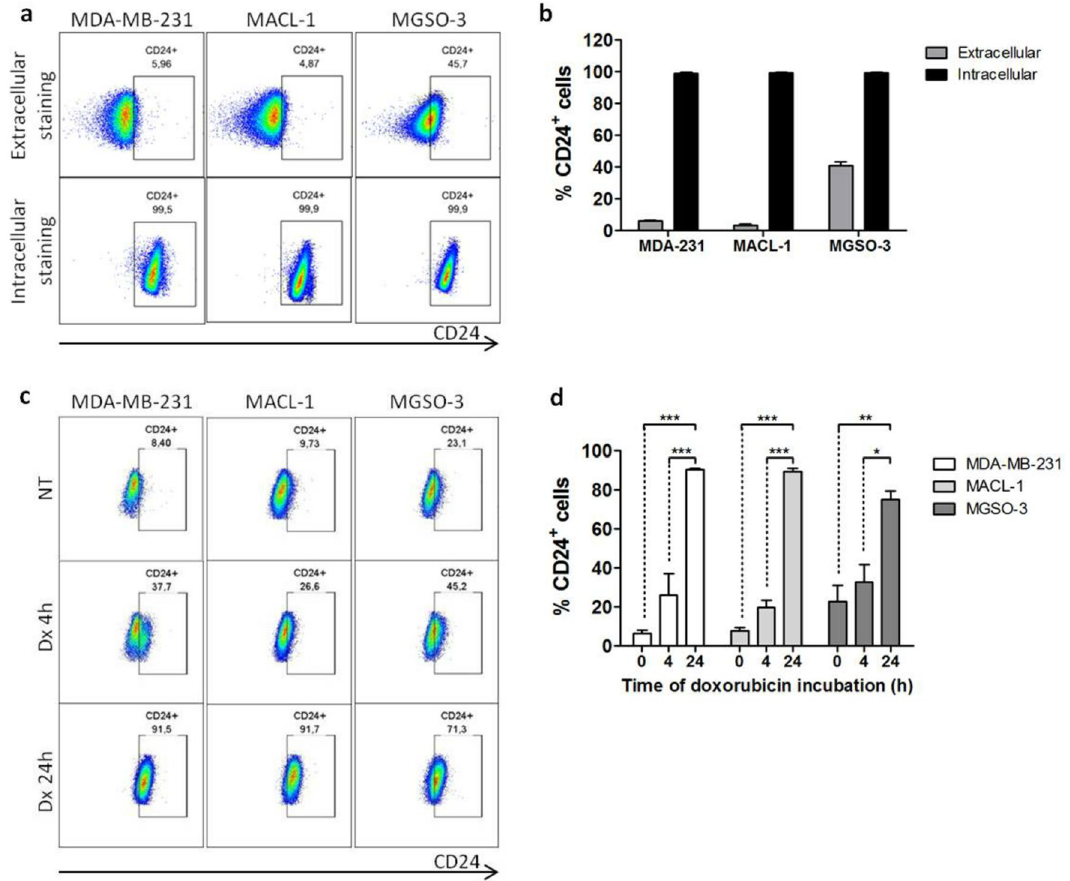
Figure 2. Translocation of CD24 from cytosol to membrane is observed in patient-derived breast cancer cells under drug stress. ( a ) Localization of CD24 in MDA-MB-231, MACL-1 and MGSO-3 cells after staining with anti-CD24/Pe-Cy7 (extracellular and intracellular staining). Dot-plots are representative of triplicates. ( b ) Frequency of CD24 + cells according to the detection of CD24 in membrane (extracellular) or in cytosol (intracellular). ( c ) CD24 + cell enrichment in breast cancer cell lines during Dx treatment. MDA-MB-231, MACL-1 and MGSO-3 cells were treated with Dx (0.6 μM) according to the indicated times and stained using anti-CD24/FITC. The dot-plots are representative of triplicates. ( d ) Frequency of CD24 + cells under Dx treatment according to the detection of CD24 in membrane. Data were plotted as means of triplicates ± SD. ***p < 0.001, **p < 0.01, *p < 0.05 (one-way ANOVA with bonferroni